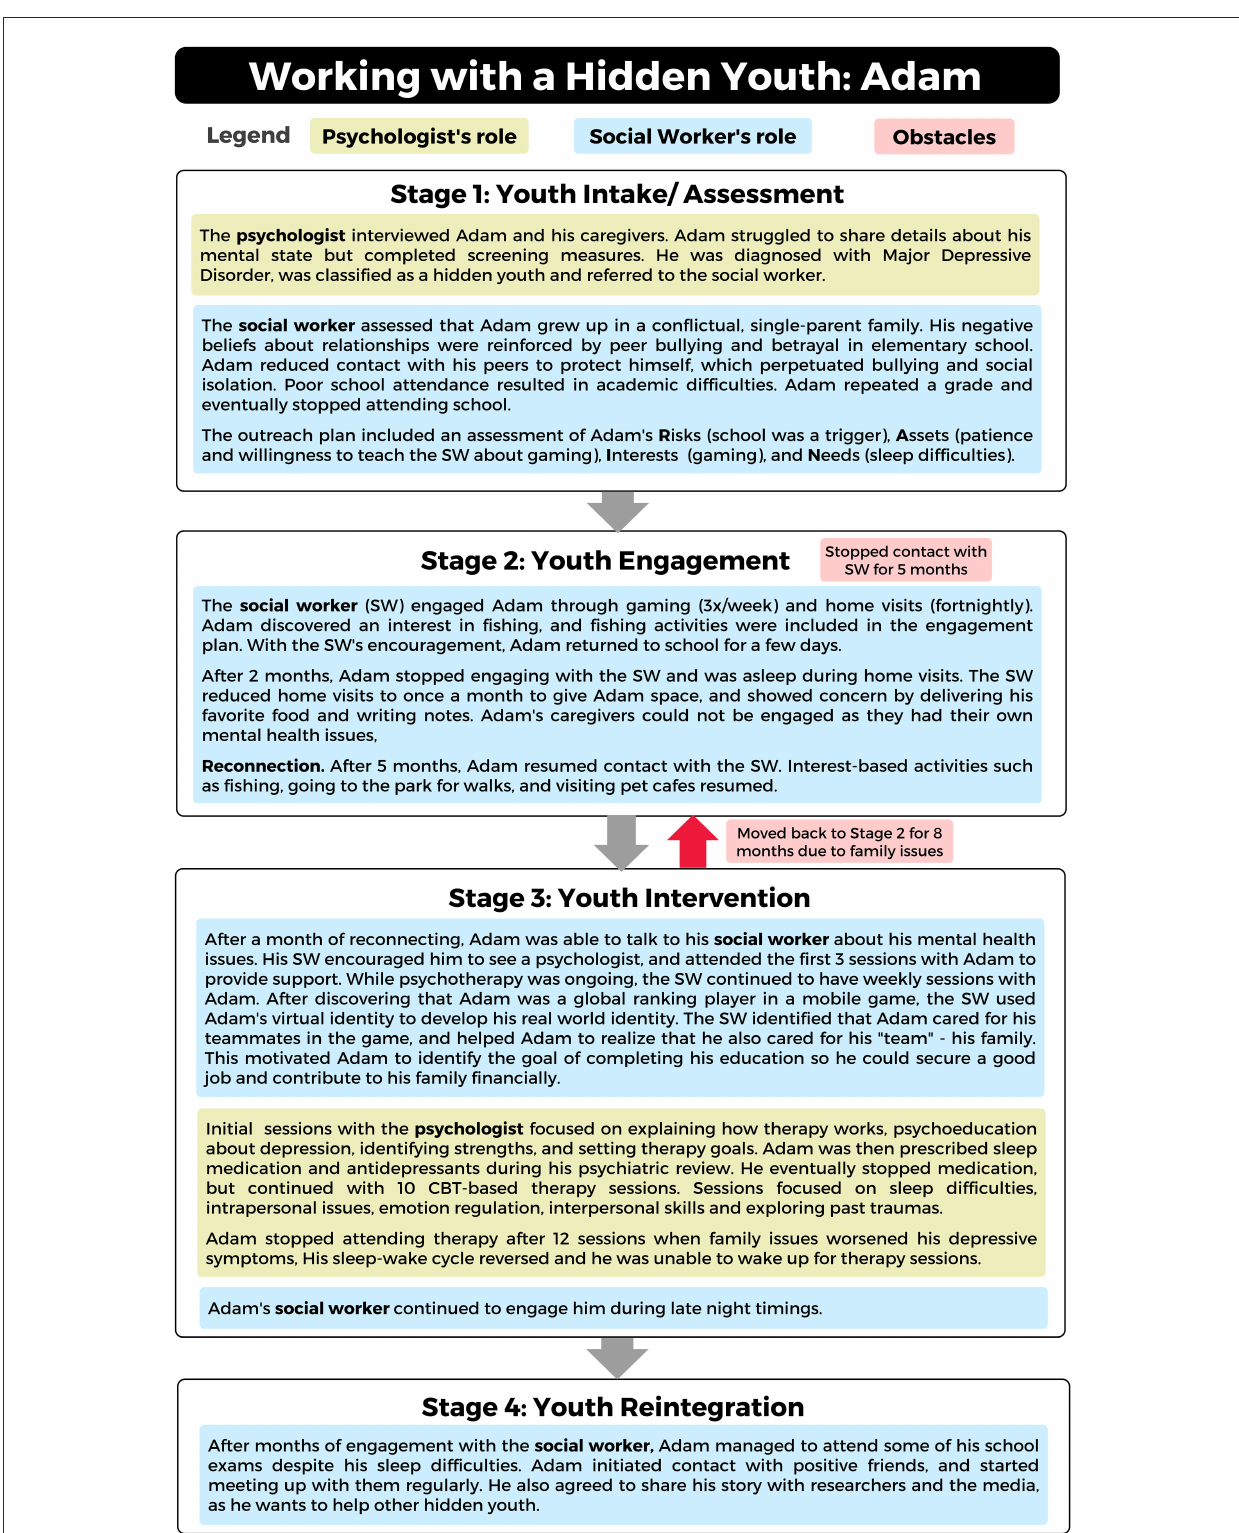
FIGURE3 Working with a hidden youth: a case study of